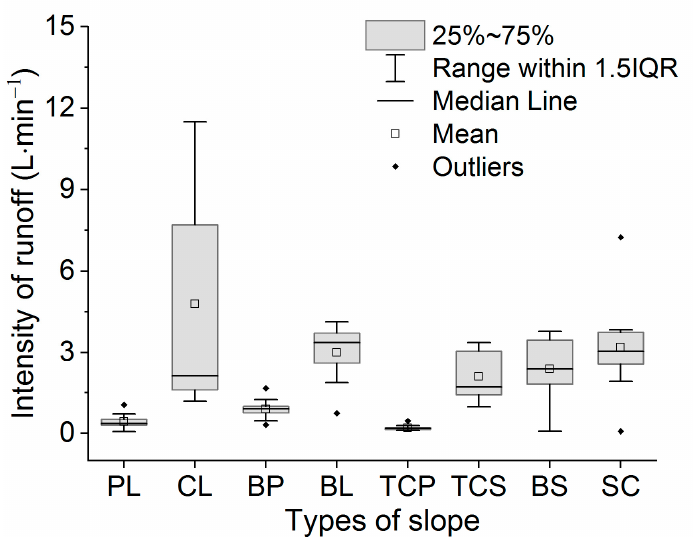
Figure 7. The average intensity of runoff with different slope treatments.